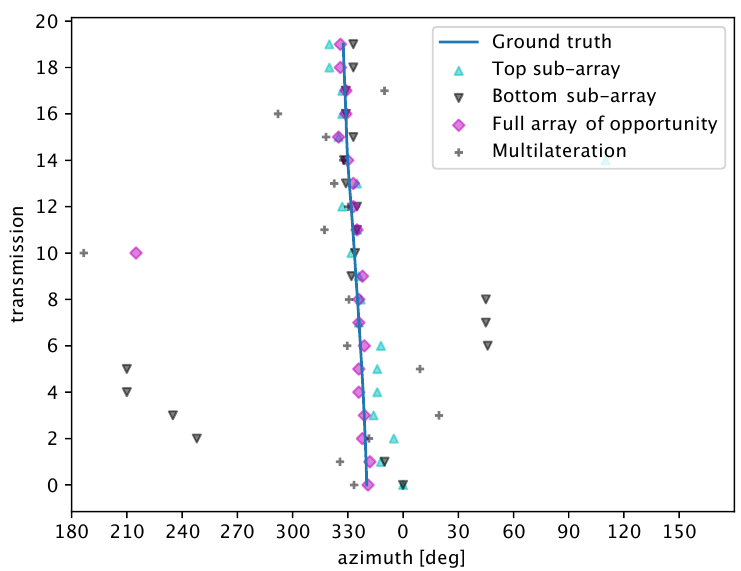
Figure 13. Results of the target localization experiment in the Werbellin lake using the SYMBIOSIS array of opportunity (cf. Section 4.3.1). While moving, the active target transmits every 2 s for 20 times. Each marker represents the azimuthal angle of arrival estimate ( x -axis coordinate) for each transmission and for the corresponding array (light blue triangles: top sub-array; dark-grey triangles: bottom sub-array; purple diamonds: full array of opportunity). Grey “ + ” markers show the azimuth estimate yielded by multilateration. Our algorithm enables the opportunistic use of two pyramidal arrays, and makes it possible to improve the azimuth estimation accuracy with respect to using a single sub-array or multilateration per se.